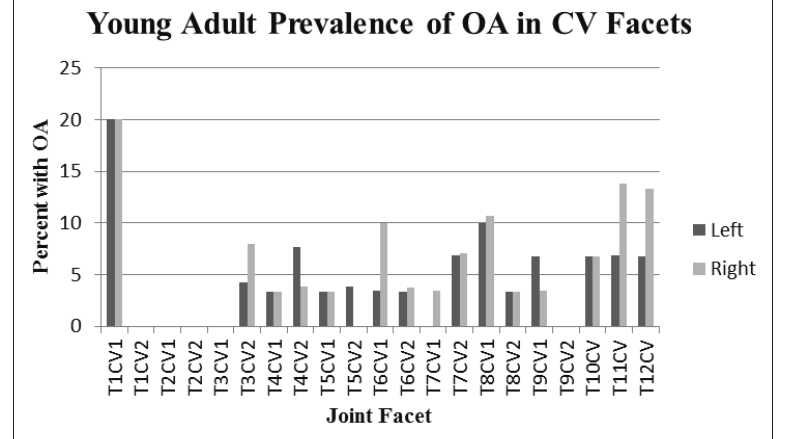
Figure 2: Prevalence of OA in CV joints in young